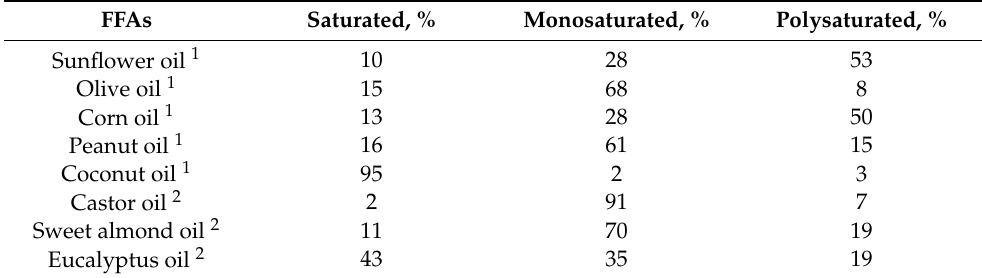
Table 1. Ratio of saturated and unsaturated fats in oils.